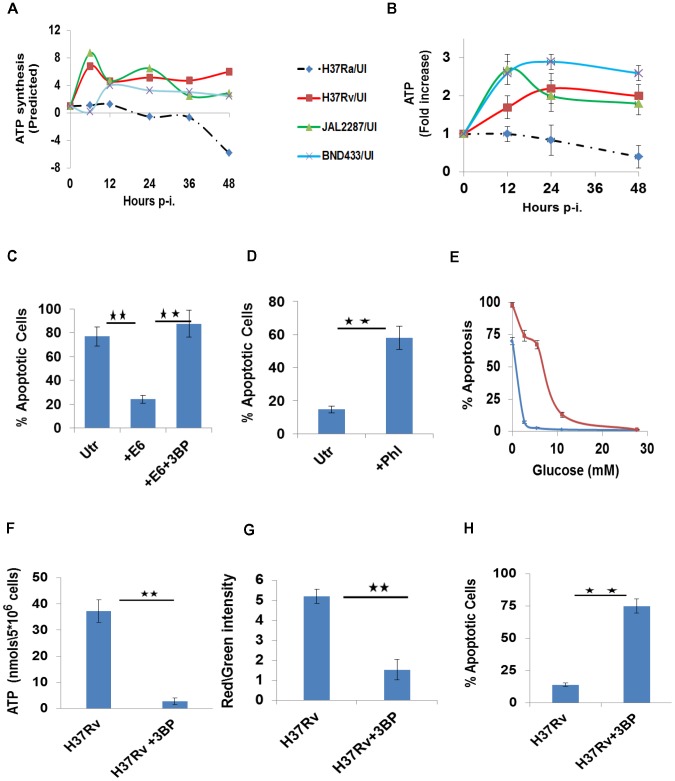
Perturbations in glycolytic flux control host cell death pathways.A. Estimated modulations in the cellular ATP synthesis rates, as a function of the duration of infection with the individual strains, are depicted as a ratio over the basal values in UI cells. Synthesis rates were calculated from the rates of the individual glycolytic reactions as described in the text. B. ATP levels were measured at the indicated times in infected cells by LC-MS/MS. Results obtained are profiled as a fold change in ATP concentrations over the corresponding level in UI cells, at each of the time points indicated. Values are the mean (±SD) of four experiments. C. H37Ra-infected THP-1 cells were either left untreated (Utr), or treated with 0.5 µM of the recombinant ESAT-6 protein (+E6) as described earlier [13]. A parallel set was also treated with the combination of ESAT-6 and 3BP (+E6+3BP). The proportion of apoptotic cells was determined at 72 hr p-i. in all cases (n = 3, ±S.D., significance, **p≤0.01). D. H37Rv- infected cells, were either left untreated (Utr), or treated with Phloretin (+Phl) at 20 µM. 72 hr later, the proportion of apoptotic cells was determined in all cases and the results (n = 3, ±S.D., significance, **p≤0.01) are presented here. E. Glucose-dependency thresholds of UI and H37Rv-infected macrophages. Either UI (blue line) or H37Rv-infected cells (red line) were cultured in medium containing the indicated amounts of glucose. Profiles give the percent of apoptotic cells, as a function of glucose concentration, when determined 48 hr later. Values are the mean (±S.D.) of three separate experiments. F-H. H37Rv-infected cells depend on glycolytic flux for ATP generation (F), and a maintenance of both mitochondrial membrane potential (G) and cell viability (H). H37Rv infected cells were left either untreated, or were treated with 3BP in medium supplemented with Pyr. The parameters described in the individual panels were measured at 48 hr and values in each panel are the mean (±S.D.) of between 3 to 5 experiments. (Significance, **p<0.01).